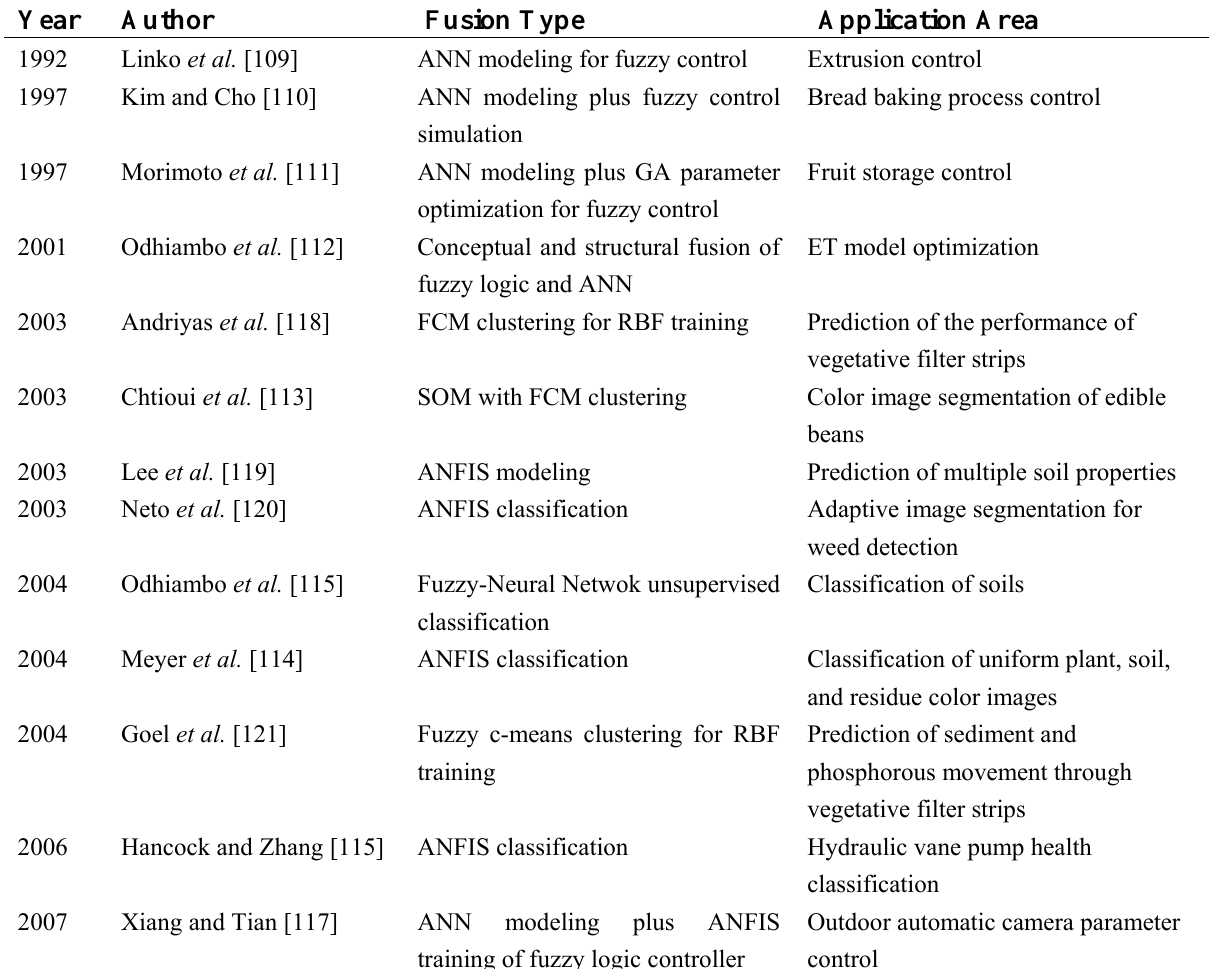
Table 1. Papers and reports on fusion of fuzzy logic and ANNs in agricultural and biological